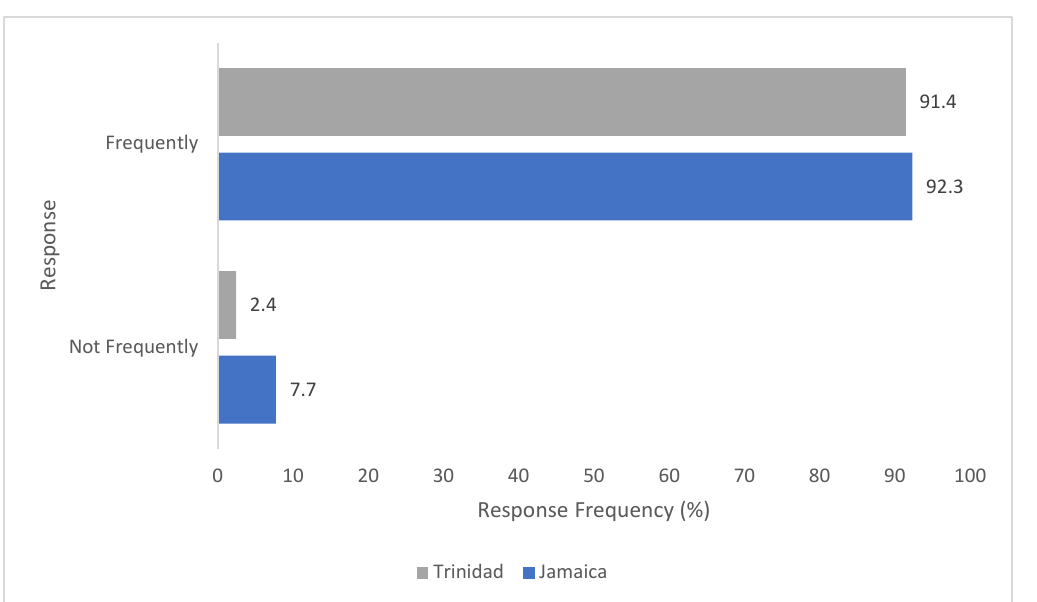
Figure 6. Comparison of how often antimicrobials are prescribed in Jamaica vs. Trinidad .